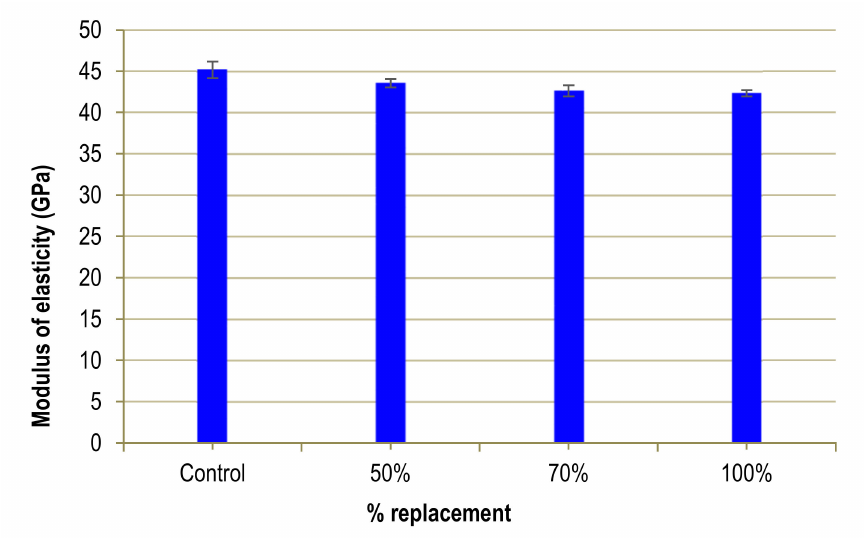
Figure 7. Modulus of Elasticity of